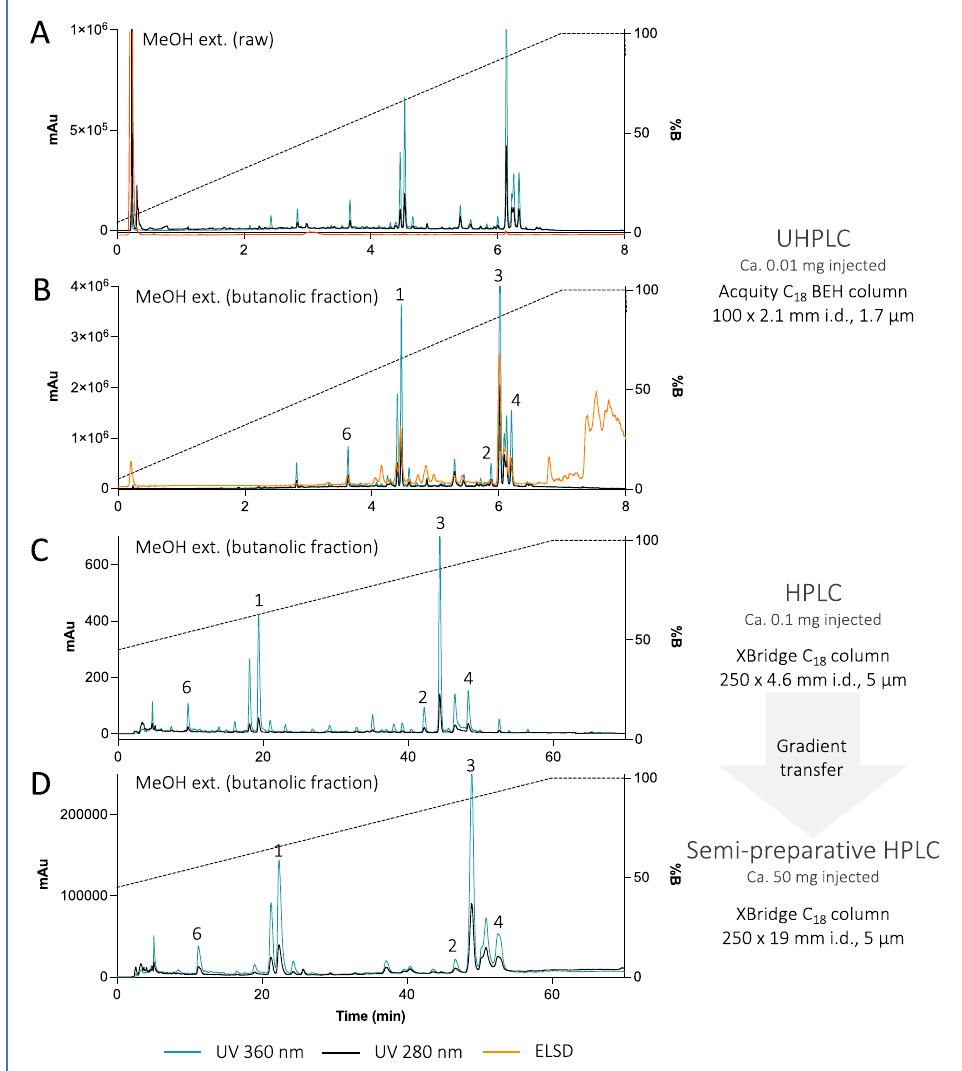
Figure 3. ( A , B ) UHPLC-PDA-ELSD analysis of the raw MeOH extract of Ophiura sarsii and its butanolic fraction. ( C ) Optimized HPLC-PDA-ELSD analysis of the MeOH extract (butanolic fraction) of O. sarsii . ( D ) semi-preparative HPLC-UV analysis after gradient transfer using a dry load injection. See Supplementary Figure S34 for the chromatograms of the EtOAc extract.